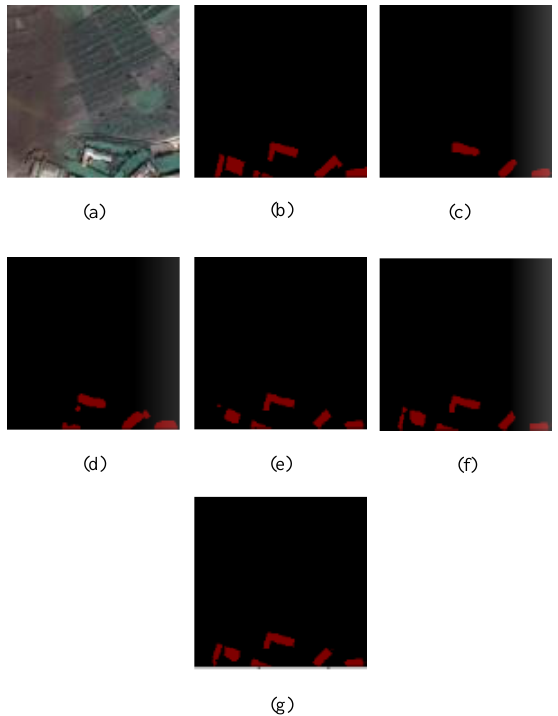
Figure 12. Comparison results of semantic segmentation methods using Satellite dataset II (East Asia). ( a ) Input image; ( b ) ground truth; ( c ) ResNet50+ASPP; ( d ) DeepLabV3+; ( e ) ENet; ( f ) ESPNet; ( g ) Our method(LResNet50+WASP(AVE)+GFG).